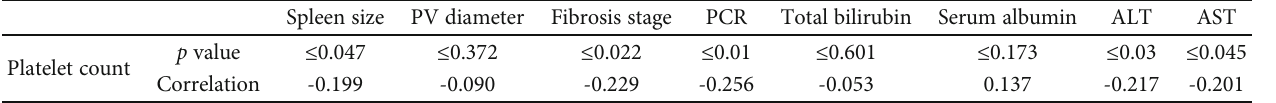
Figure 5: Platelet count at baseline (a) and end of treatment (b) in relation to di ff erent stages of hepatic fi brosis. Table 4: Correlation between baseline platelet count, imaging, and laboratory